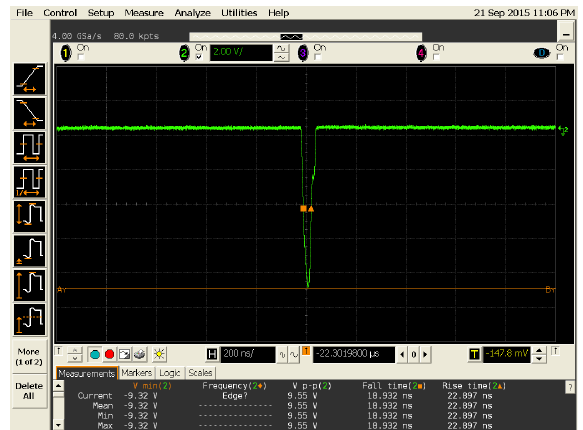
Figure 7: output waveform Gaussian measured using SRD from MA44769-287T